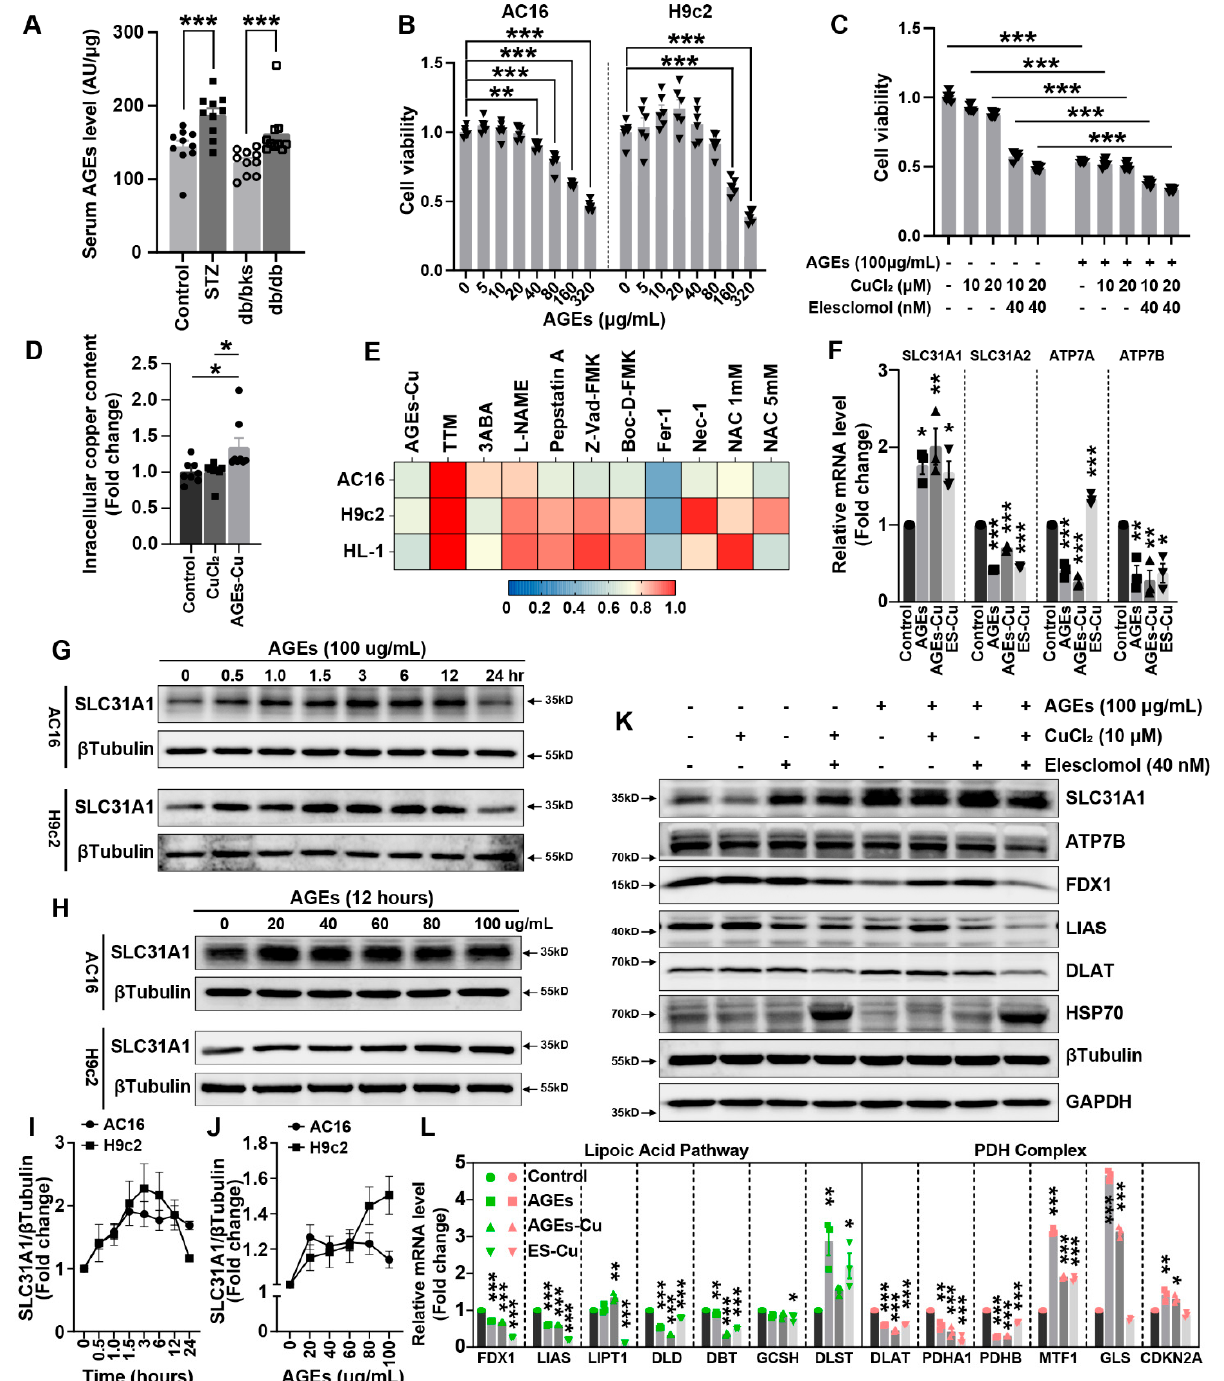
Figure 2. AGEs induce cuproptosis in cardiomyocytes. ( A ) Serum levels of AGEs in STZ-induced and db/db-diabetic mice. ( B ) Viability of AC16 and H9c2 cells after treatment with AGEs of indicated concentration. ( C ) Viability of AC16 cells after treatment with AGEs (100 µ g/mL) and indicated elesclomol–Cu. ( D ) Intracellular copper content in cardiomyocytes after AGEs (100 µ g/mL) and/or CuCl 2 (10 µ M) treatment. ( E ) Heatmap of viability of AC16, H9c2 and HL-1 cardiomyocytes pretreated with 20 μ M necrostatin-1, 10 μ M ferrostatin-1, 1mM N-acetylcysteine (NAC), 5 mM NAC, 30 μ M Z-VAD-FMK, 50 μ M D-Boc-FMK, 20 μ M TTM, 300 μ M L-NAME, 1 μ M pepstatin A or 10 μ M 3-ABA for 12 h and then treated with AGEs (100 μ g/mL)-Cu (10 μ M) for 48 h. ( F ) mRNA levels of copper ion transporter in AC16 cells treated with AGEs, AGEs–Cu or ES–Cu for 24 h. ( G ) Western blot analysis of SLC31A1 in AC16 or H9c2 cells treated with AGEs, with indicated time-points. ( H ) Western blot analysis of SLC31A1 in AC16 or H9c2 cells treated with AGEs with gradient